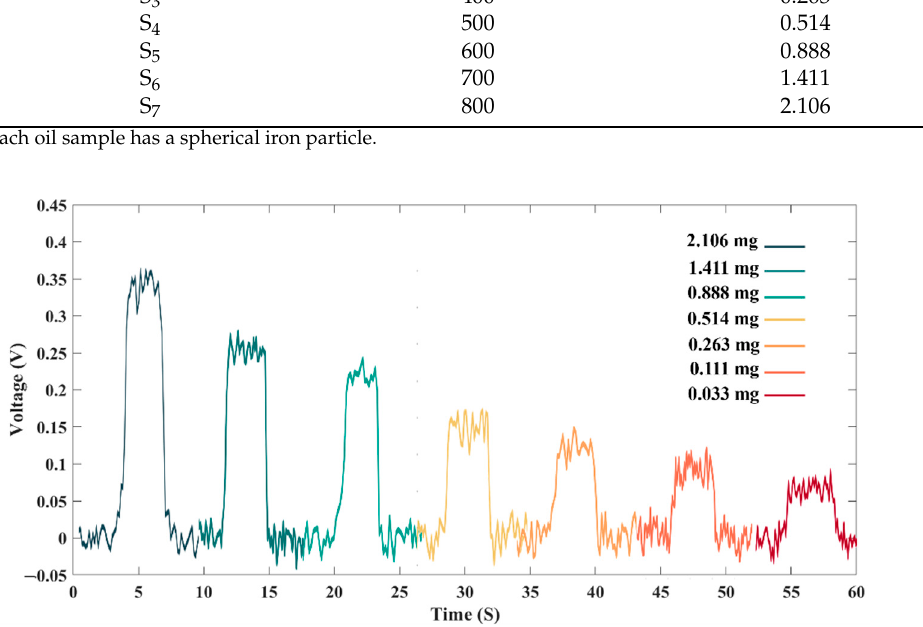
Figure 8. Response of the sensor to different masses of debris.